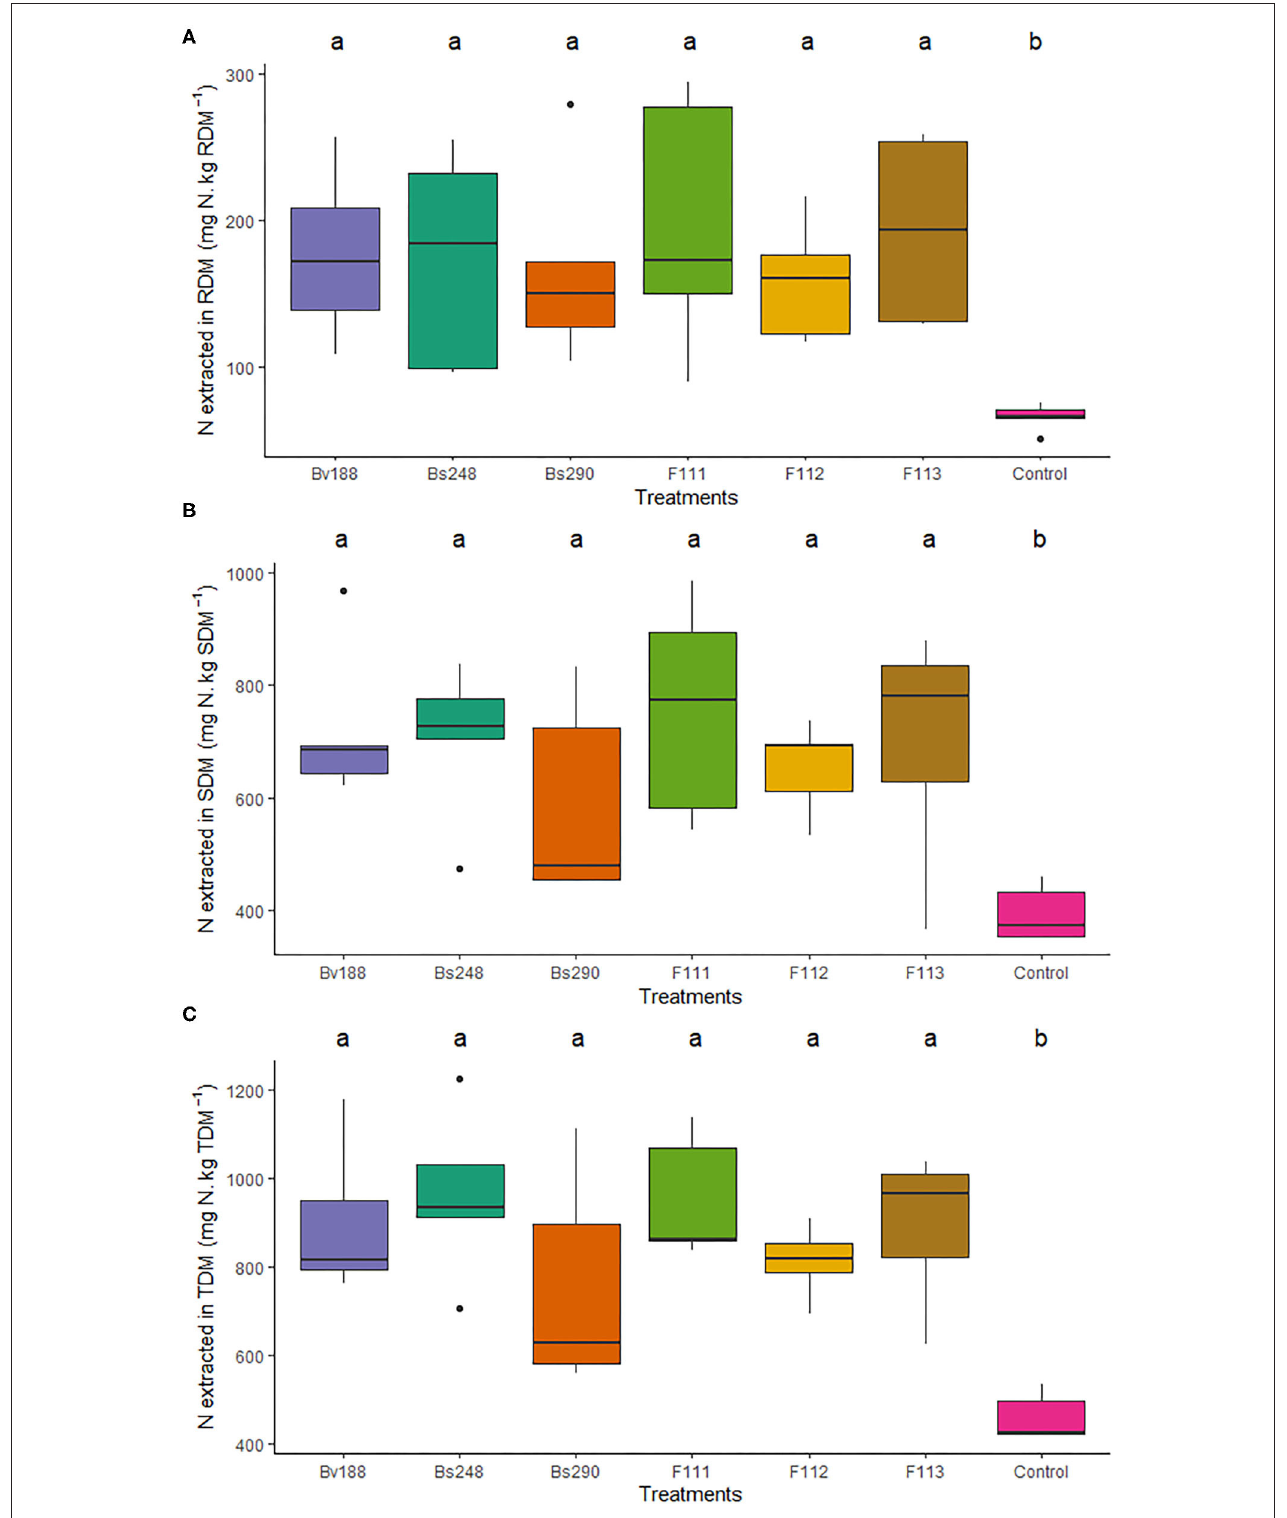
FIGURE 1 | Boxplots (median and quartiles) of N extracted from the roots (A) , shoots (B) , and total dry matter (C) of cotton plants inoculated with the treatments. Different letters in the rows indicate significant differences between means (Duncan’s, p < 0.05). RDM, root dry matter; SDM, shoot dry matter; TDM, total dry matter; Bv188, Bacillus velezensis strain Bv188; Bs248, Bacillus subtilis strain Bs248; Bs290, B. subtilis strain Bs290; F111, Aspergillus brasiliensis ; F112, Aspergillus sydowii ; F113, Aspergillus sp. versicolor section; Control, no